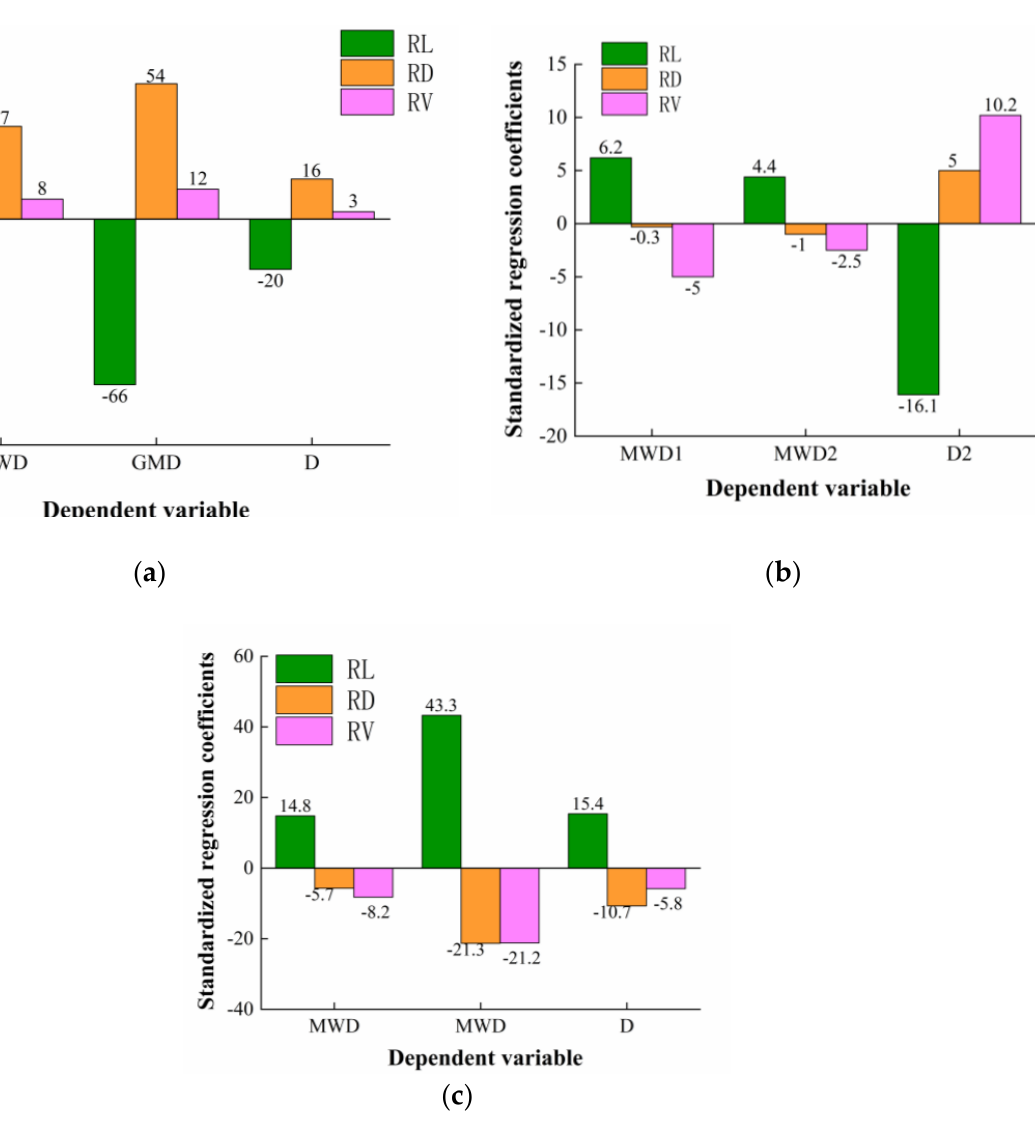
Figure 14. Standardized regression coefficient graph. ( a ) Paspalum notatum Flugge; ( b ) Setaria viridis; ( c ) Cynodon dactylon (L.).